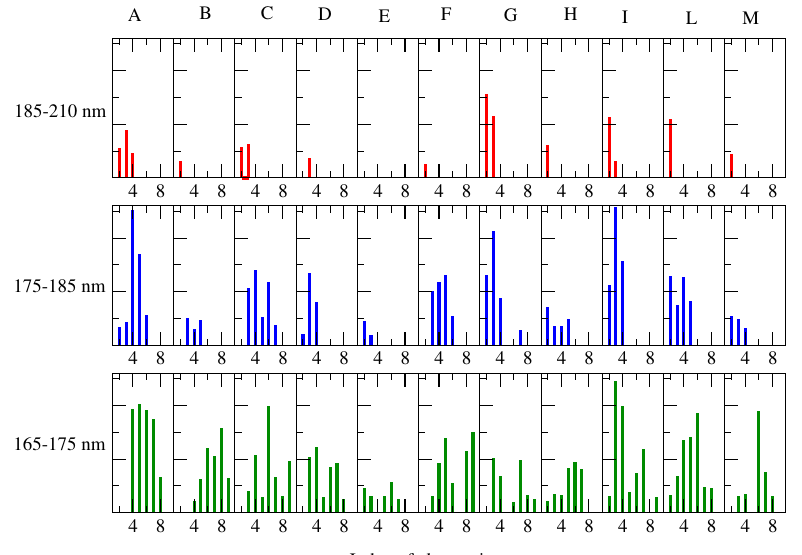
Figure 10. Weight of each of the electronic ground-excited (perturbed) state transitions, involved in the calculated ECD spectra of Alpha-Glu for each RC conformation (indicated in the upper side), as obtained by considering their perturbed maximum intensities. Note that for clarity, only the transitions showing a maximum intensity higher than 1.0 M − 1 cm − 1 were taken into account.